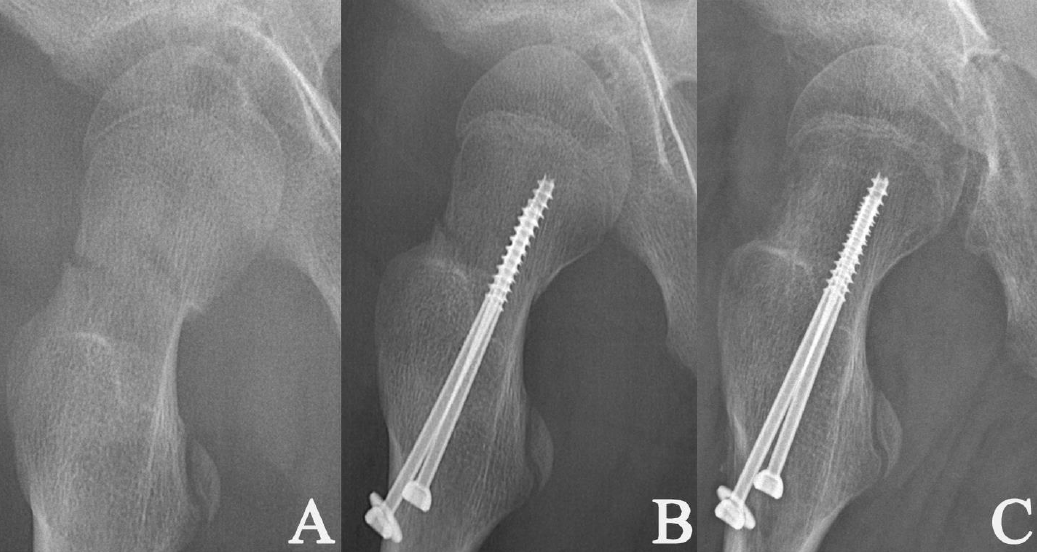
Figure 3. Radiographs of a 9-year-old girl with a displaced Delbet – Colonna type II fracture [15] ( A ); radiographs after closed reduction and internal fixation with two cannulated screws filling 11.9% of the femoral neck; the fracture was partially compressed by the hardware ( B ); the radiological healing at 1.9 months post-surgery ( C ).